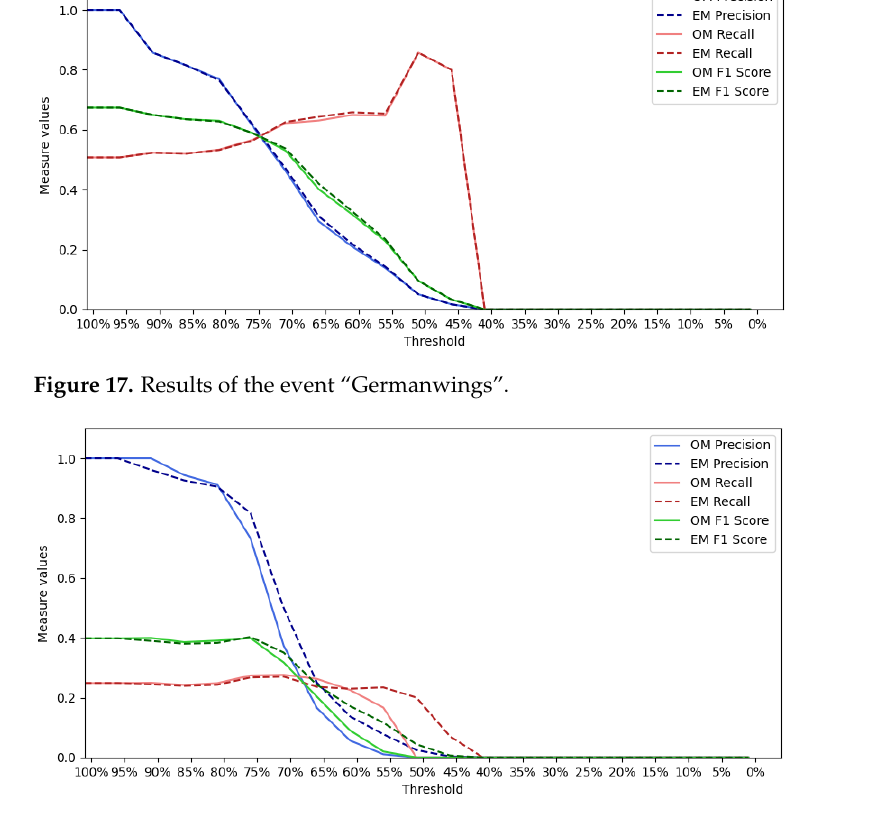
Figure 18. Results of the event “Ferguson”.